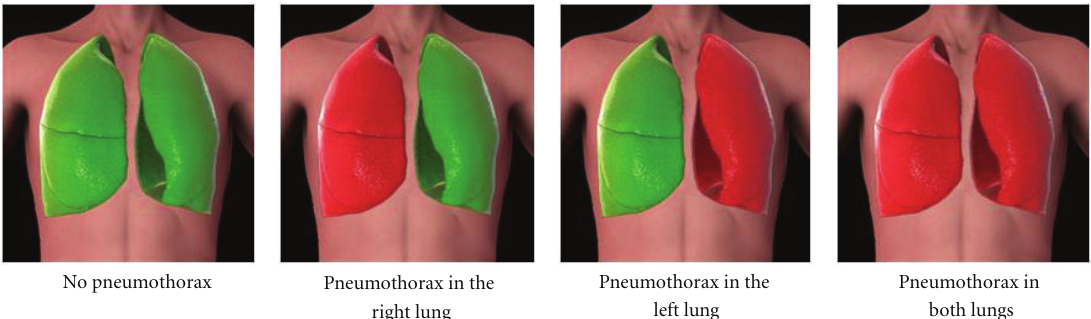
Figure 4: Example of real-time Pneumoscan data interpretation and report.